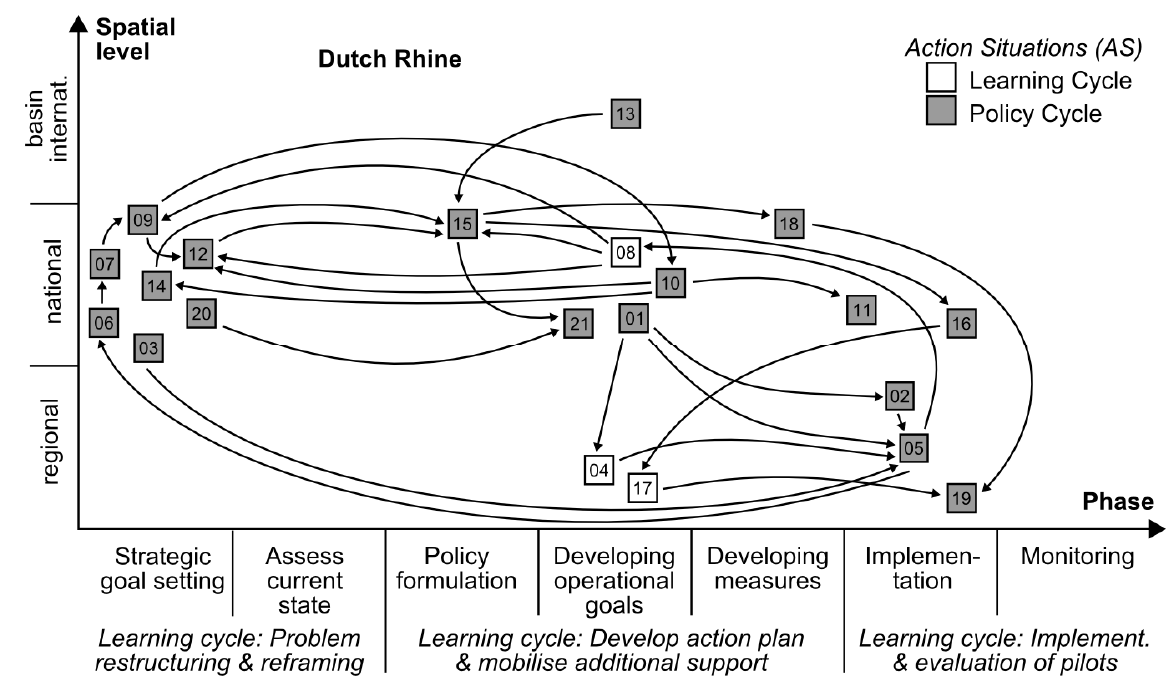
Figure A2. Formal policy and informal learning processes and their interdependencies in the Dutch Rhine. Non-aggregated version of Fig. 4. The numbers refer to the ASs as listed in Table A3.